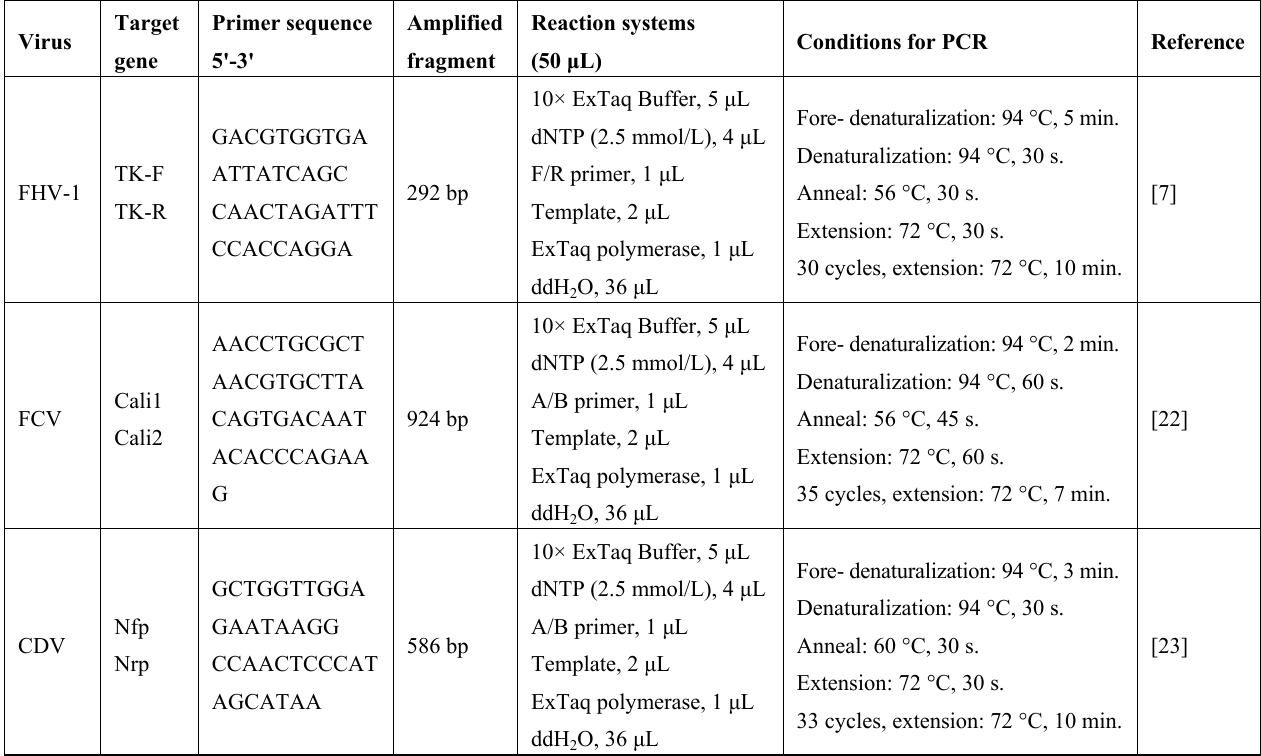
Table 2. Oligonucleotide primers, reaction systems and conditions used for the amplification of the target genes of the three suspected